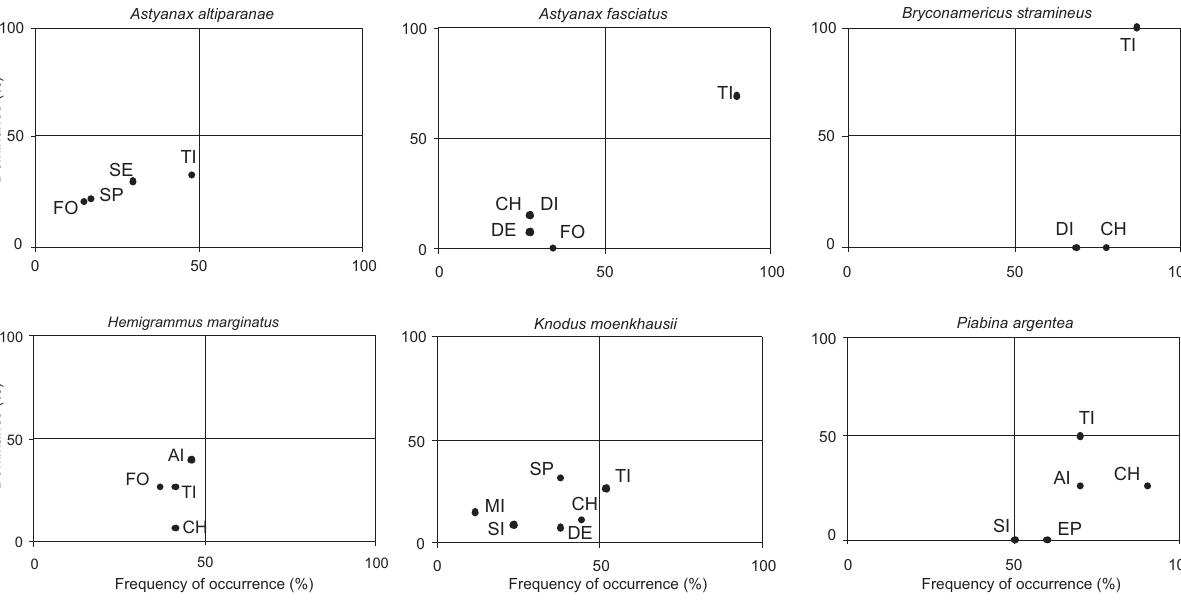
Figure 5. Frequency of occurrence (axis x) and dominance (axis y) of feeding items registered in gut contents of six nektonic species studied. (AI) Aquatic insects debris, (CH) Chironomidae larvae, (DE) detritus, (DI) Diptera aquatic larvae, (EP) Ephemeroptera nymphs, (FO) Formicidae in adult stages, (MI) Microspora sp., (SE) seeds of terrestrial plants, (SI) Simuliidae aquatic larvae, (SP) Spyrogira sp., (TI) terrestrial insects